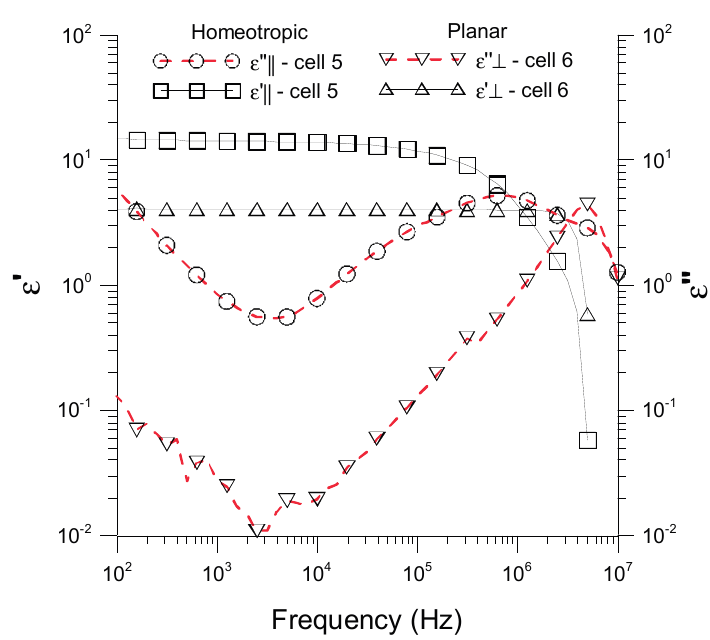
Figure 2. Experimental data of the complex dielectric permittivity of NLC 6290 cells as a function of the frequency of an applied electric field and for both planar and homeotropic cells, at a room temperature of 30